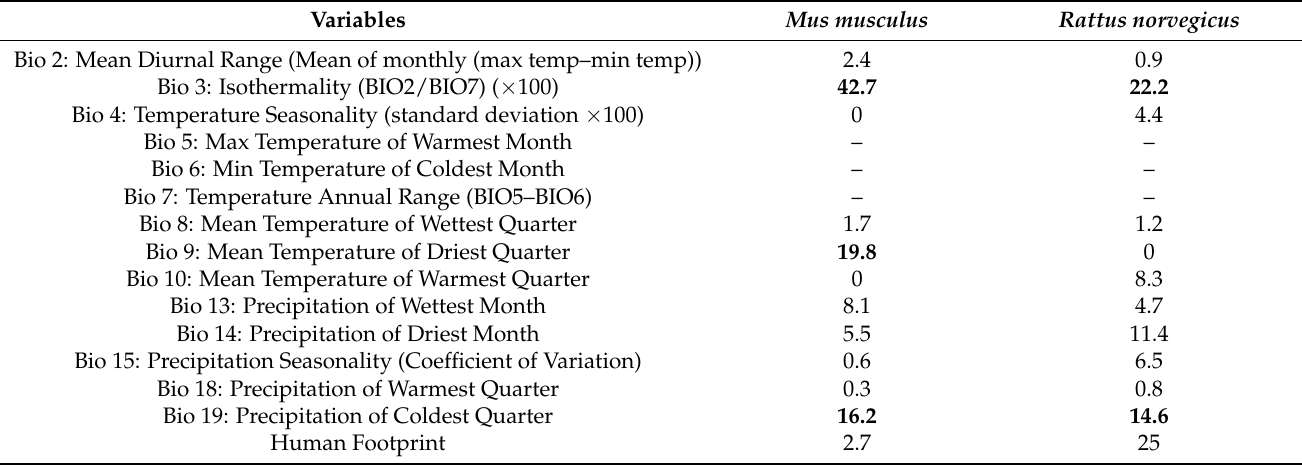
Table 2. Percent contribution of environmental variables for Mus musculus and Rattus norvegicus when the human footprint was added to the model. Variables contributing the most are shown in bold for each